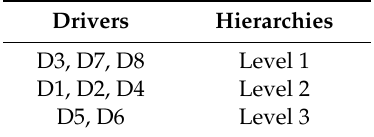
Table 7. Level matrix of the drivers of